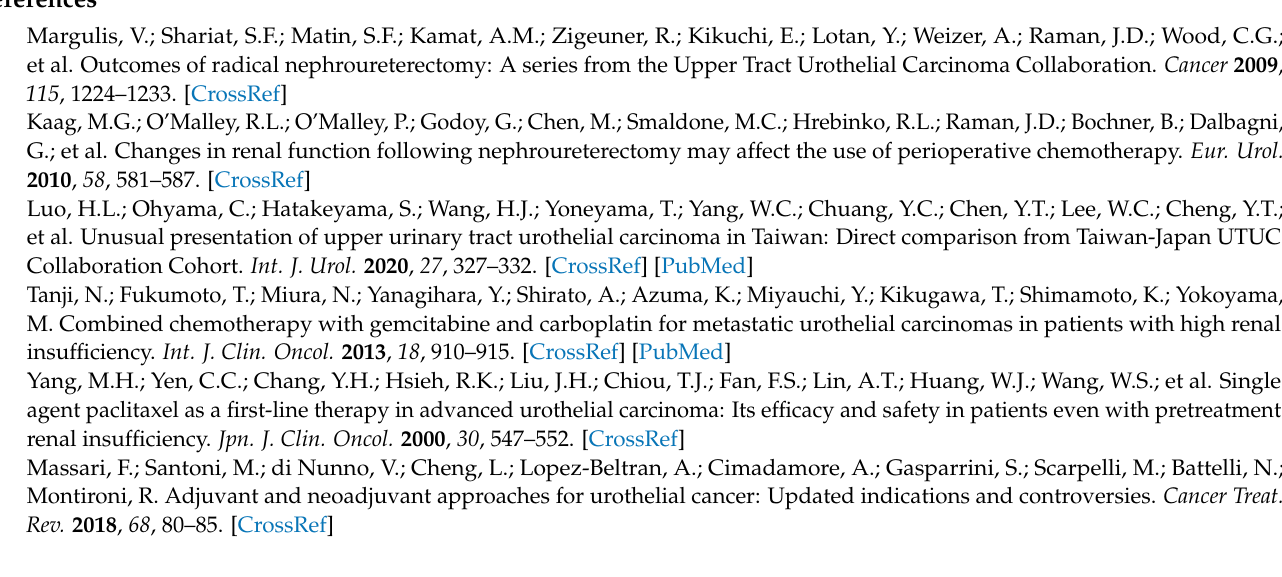
caspase-3 and caspase-9 apoptosis signaling, Figure S2: RNAi-mediated down-regulation of ZO-1 or assay, Figure S3: Full unedited gels for Figure 4C, Figure S4: Detail information about UTUC PDO culture and drug assay with shock wave